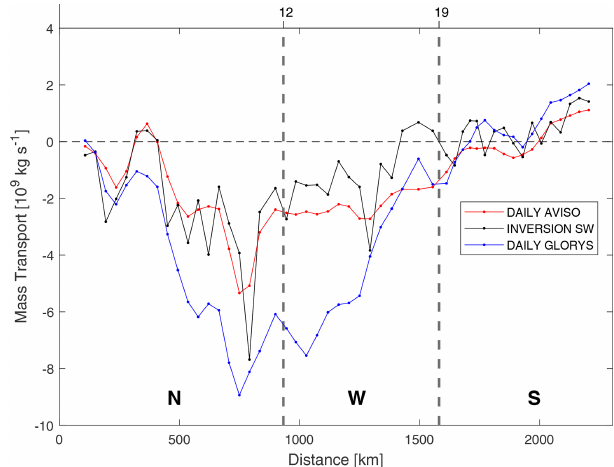
Figure 12. Accumulated mass transports in the first layer of SW estimated along the N, W and S transects (without WOA stations) with altimetry-derived geostrophy (red line), inversion (with GLO- RYS data as reference velocities, black line) and the GLORYS field (blue line). Negative (positive) values indicate inward (outward) transports, as in Fig. 11. The northwestern and southwestern cor- ners (at stations 12 and 19) are indicated by vertical dashed